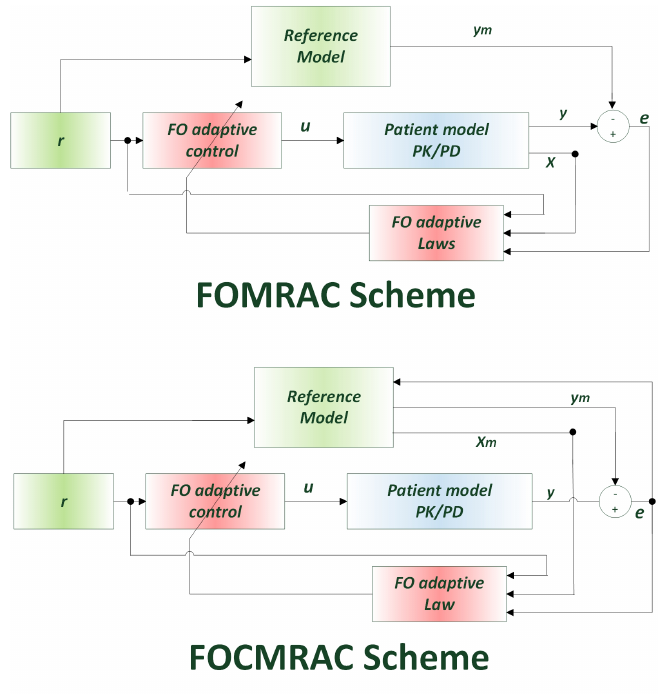
Figure 8. FOMRAC and FOCMRAC schemes implemented.